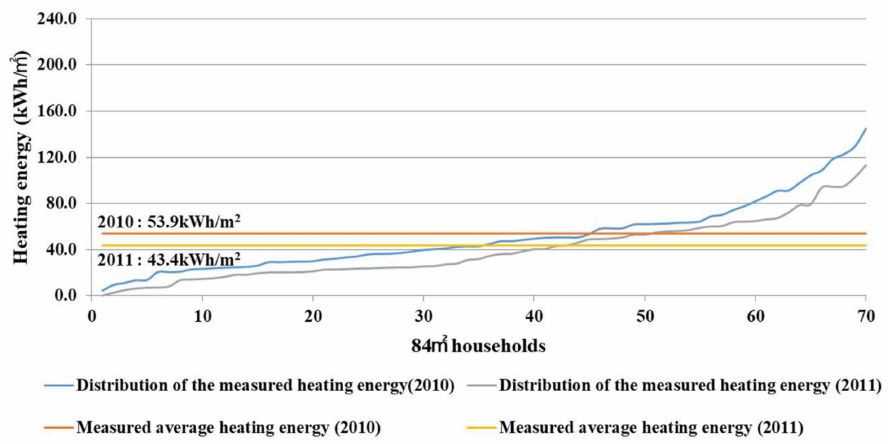
Figure 3. Analysis of the measured heating energy consumption of households sized 84 m 2 in 2010 and